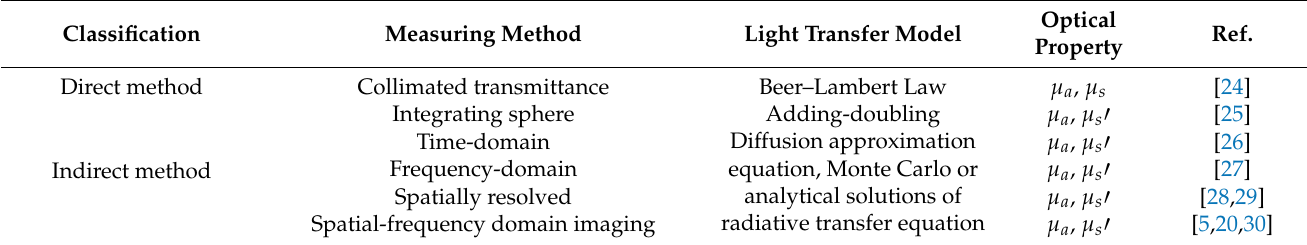
Table 1. Commonly used optical methods for measuring optical properties of biological